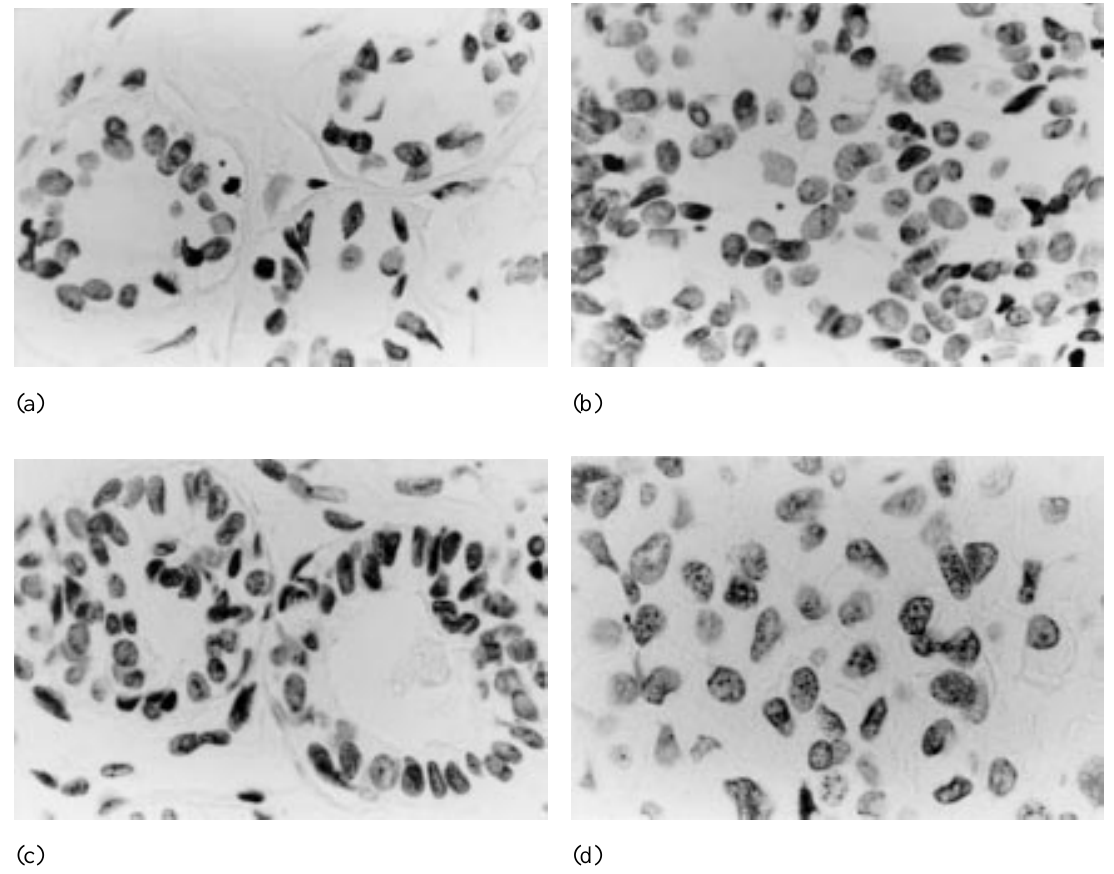
Fig. 1. Example of an usual ductal hyperplasia patient without adjacent invasive carcinoma (a, b) and an usual ductal hyperplasia patient with adjacent invasive carcinoma (c, d). Differences in chromatin patterns are seen between normal-appearing ducts (a and c), and even more apparent in the hyperplastic cells (b and d). Slides were Feulgen stained as described in Material and methods (100 (cid:2) objective